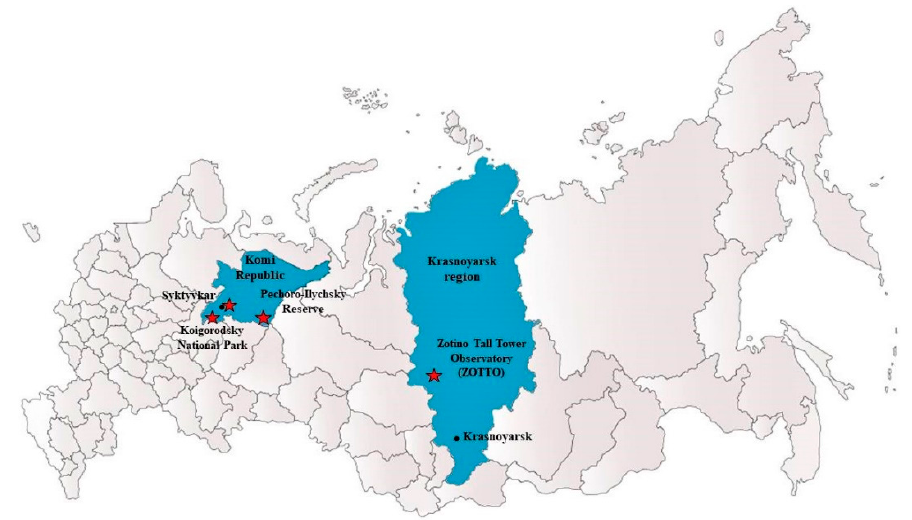
Figure 1. Location of the research area. The study sites are marked with stars. The objects of the study in the Krasnoyarsk region were located in the vicinity of the ZOTTO International Observatory. Sites I-CS and II-CS were located on the left bank of